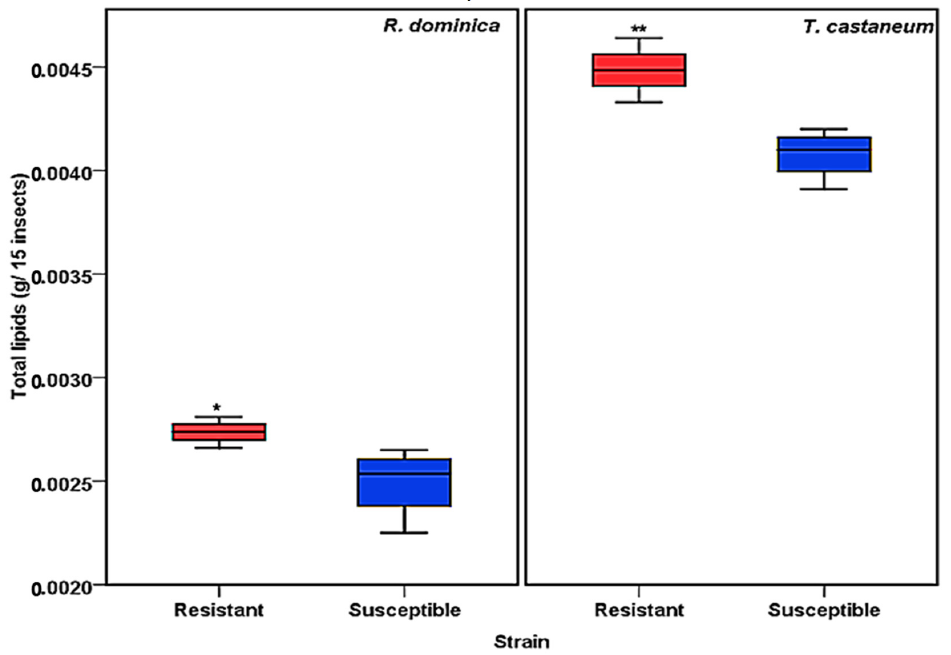
Figure 1. Total lipid content obtained from phosphine-susceptible and -resistant strains of R. dominica and T. castaneum . Each value in the figure represents the average of four biological insect sets. The values were statistically analyzed by t -test. * = p ≤ 0.01, ** = p ≤